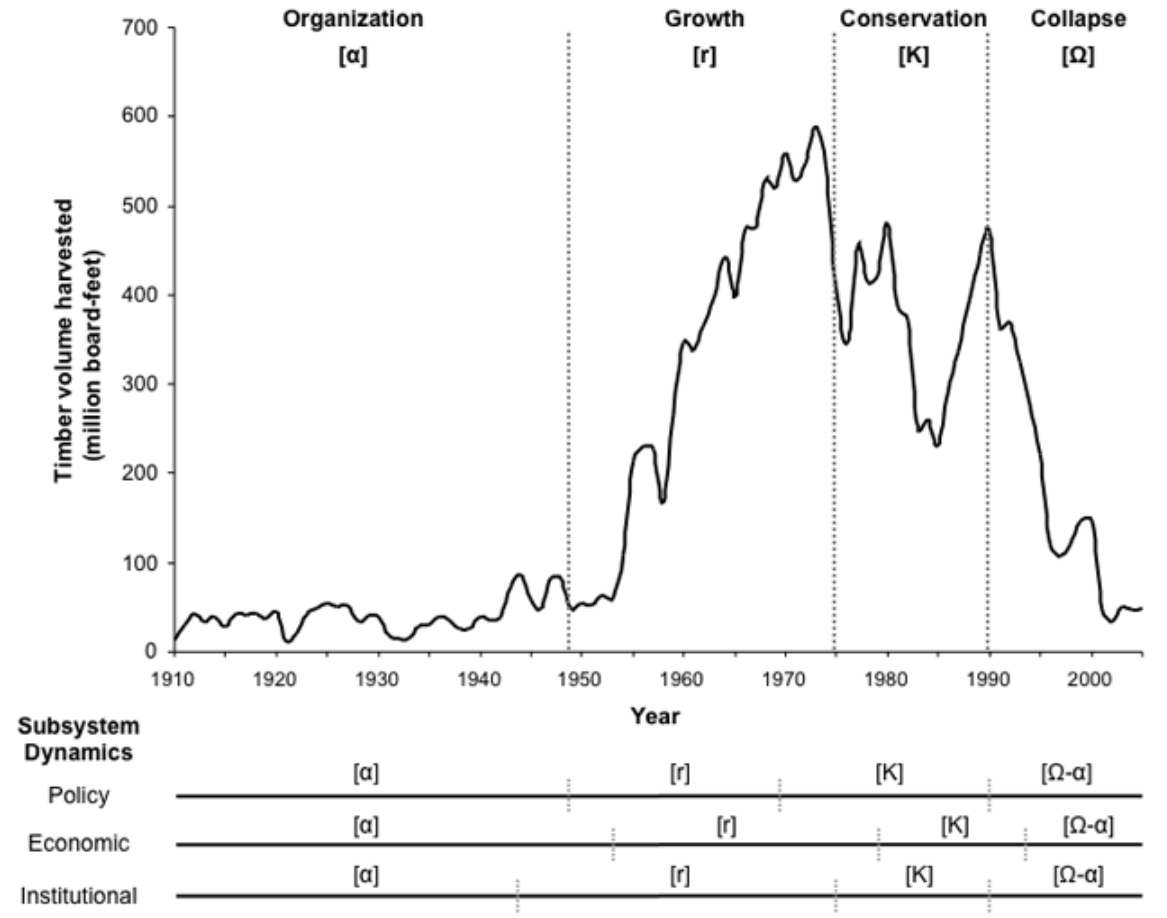
Fig. 2. Longitudinal analysis of annual timber harvest outputs from the Tongass National Forest and subsystem dynamics (see Appendix 2), divided into the four phases of the adaptive cycle: organization, growth, conservation, and